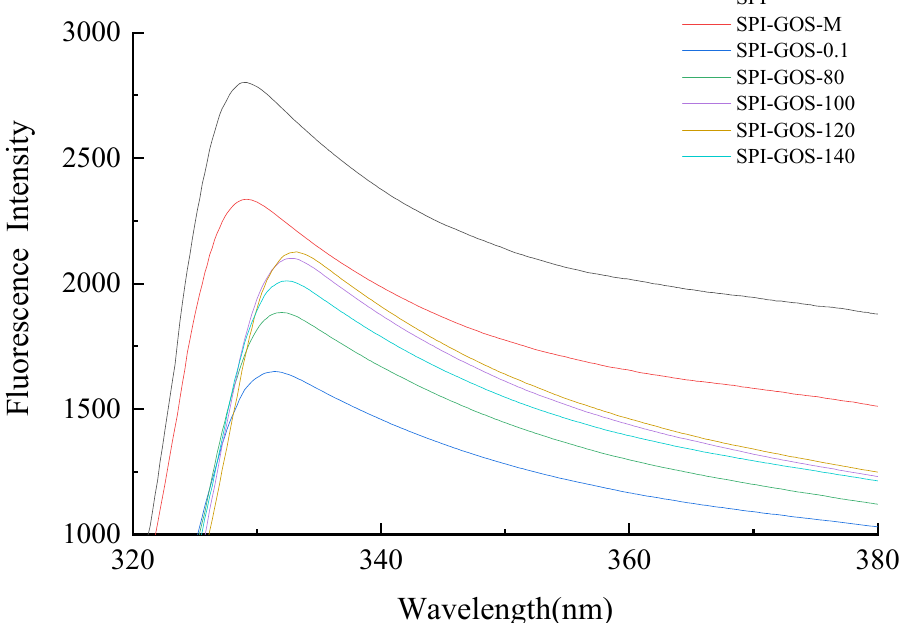
Figure 8. Intrinsic fluorescence spectra of the samples. SPI is the native soy protein isolate; SPI- GOS-M represents the mixture of SPI and GOS; SPI-GOS-0.1 represents the traditional wet heating Maillard reaction group; SPI-GOS-80, SPI-GOS-100, SPI-GOS-120, and SPI-GOS-140 are the HPH treatment groups.